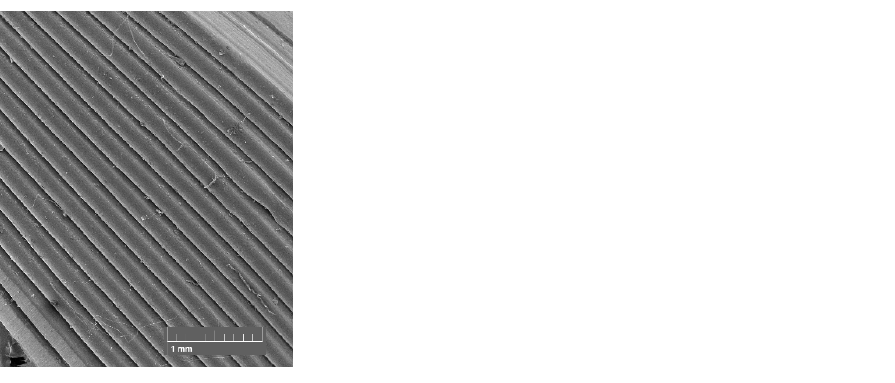
Figure 16. SEM micrograph of the 3D-printed static mixer from pure PET-G at 50× magnification .